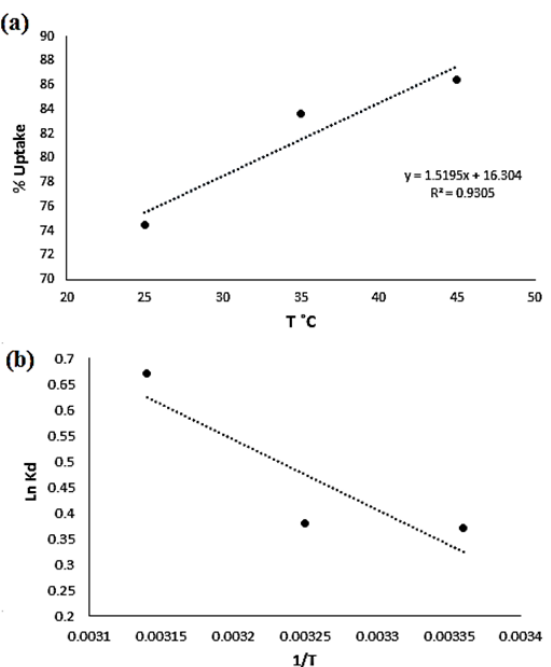
Figure 11. ( a ) The % uptake of Cd(II) vs. temperature; ( b ) a plot of lnK d vs. 1/T(K) for Cd(II) and Fe(III) at pH = 4.00.